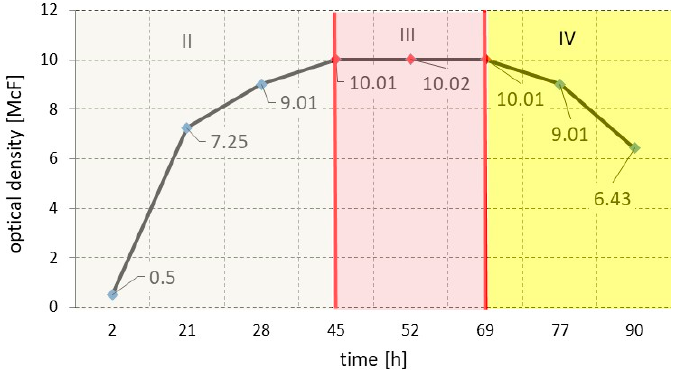
Figure 4. The curve of bacterial growth of Staphylococcus aureus ATCC 25923.